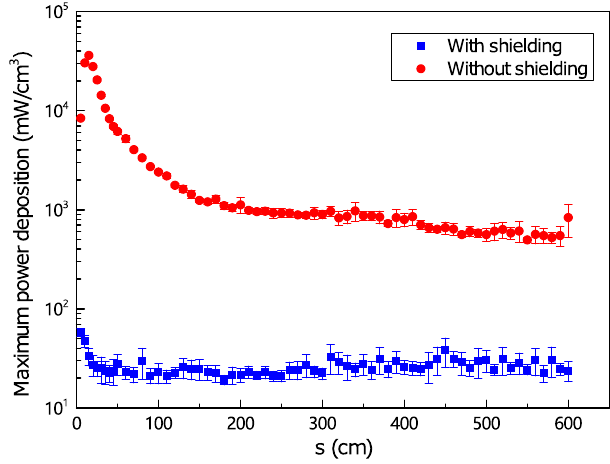
FIG. 15. Maximum power deposition along the QD before and after the aperture optimization of the